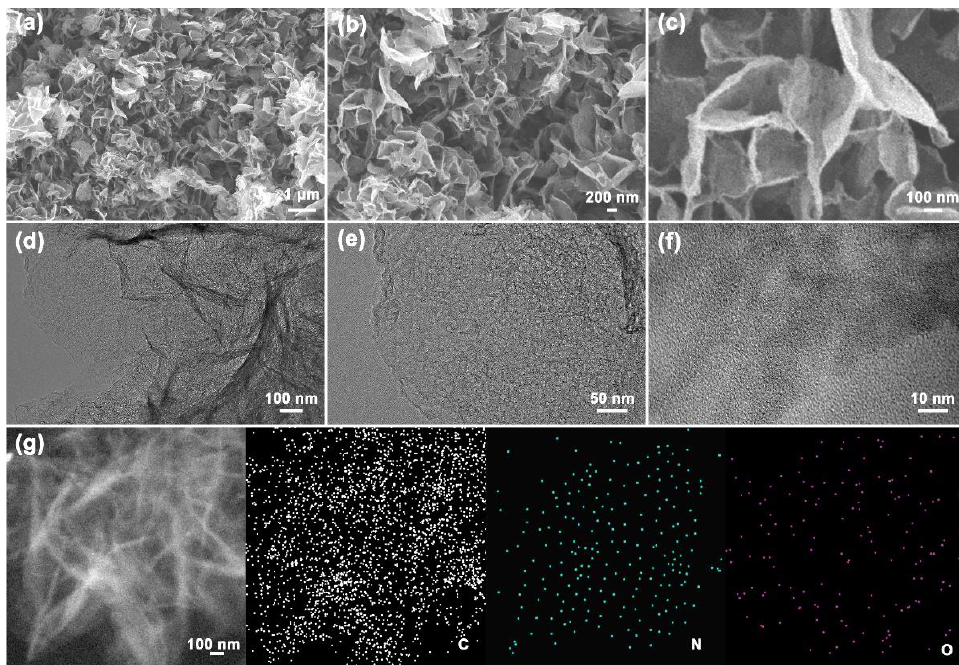
Figure 2. ( a – c ) SEM, ( d , e ) TEM, ( f ) HRTEM, and ( g ) STEM and corresponding the element mapping of C, N, and O for NPCNSs-1000.